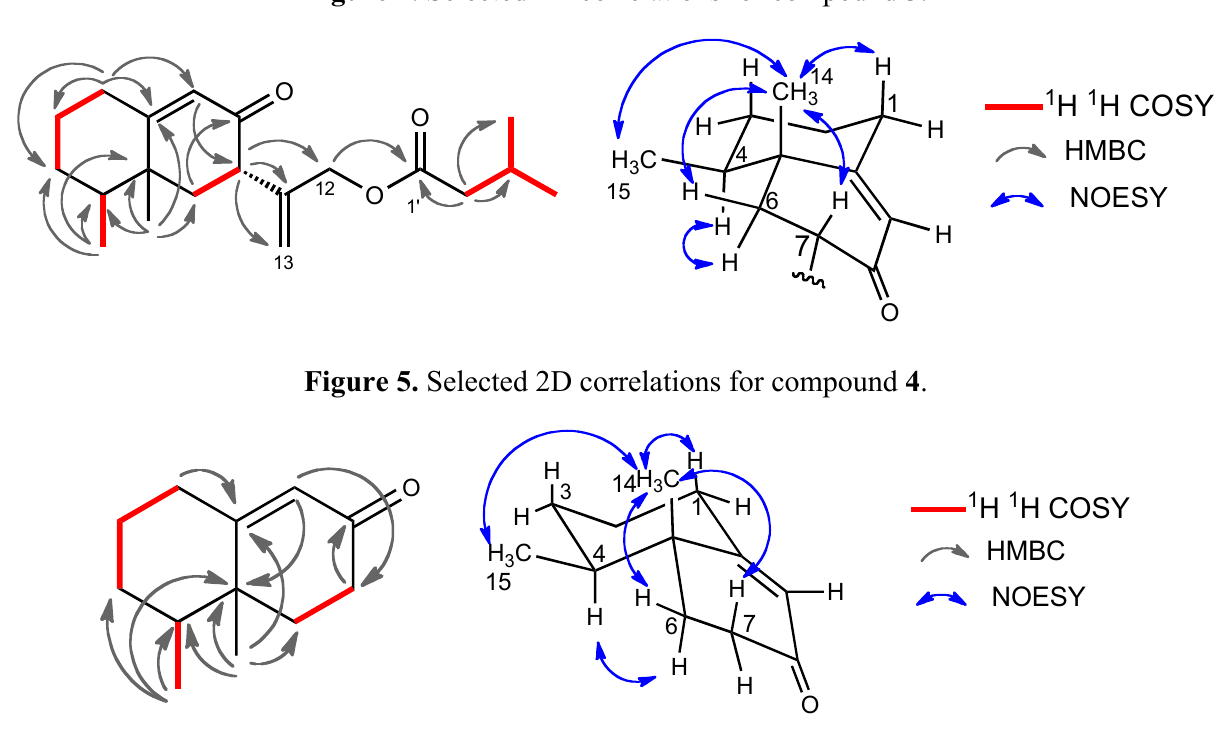
Figure 4. Selected 2D correlations for compound 3 .